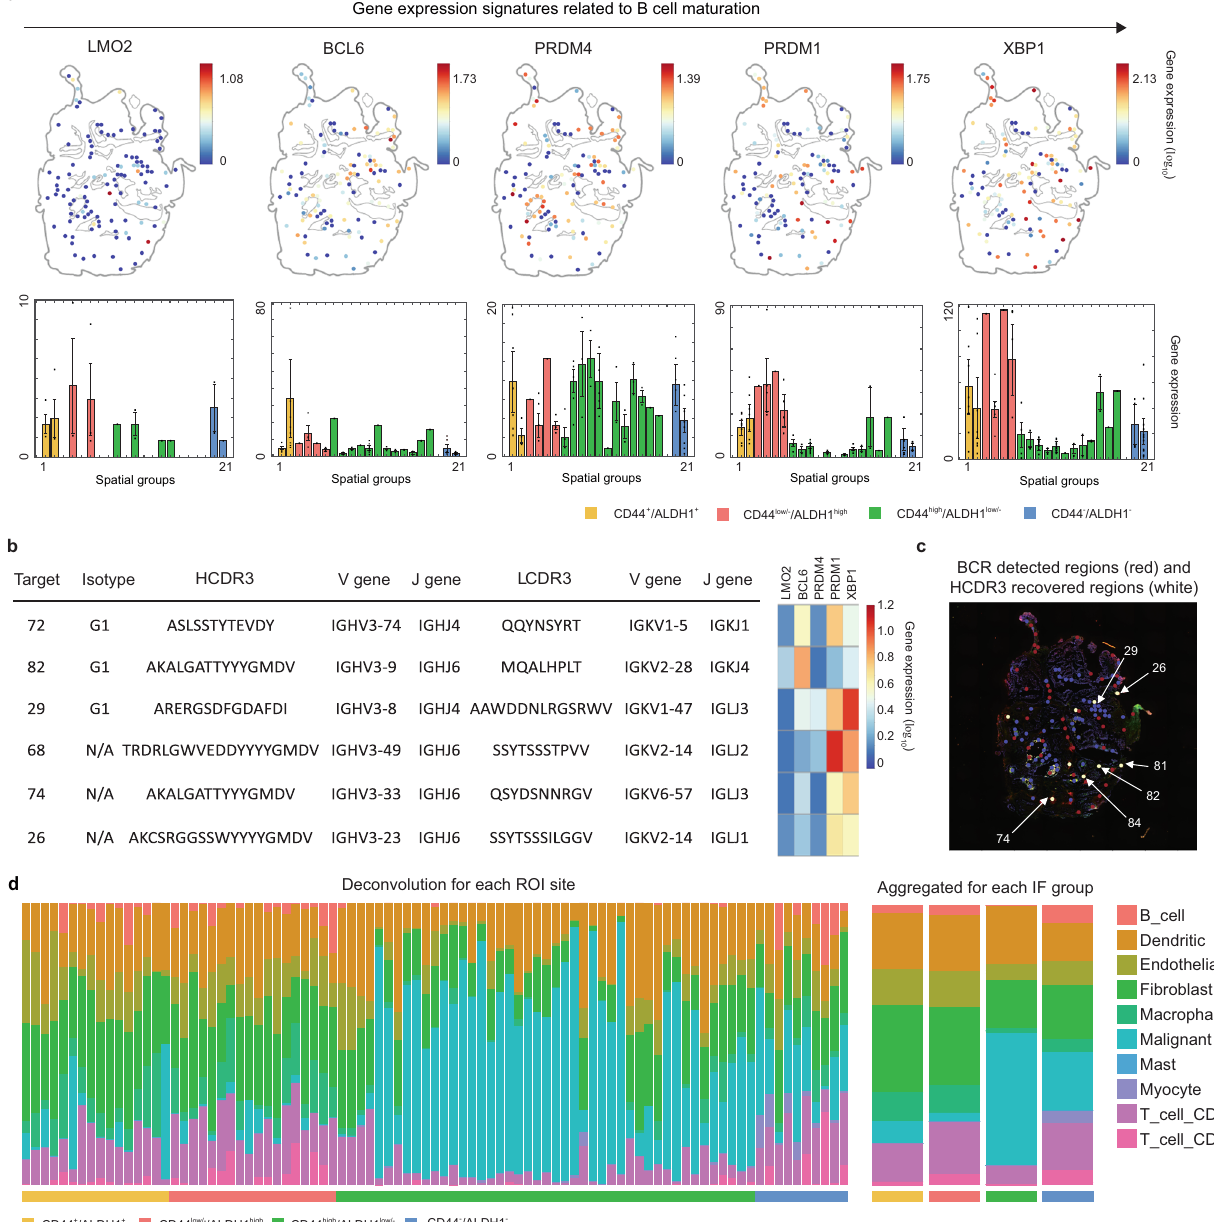
Fig. 4 Spatial analysis of the immune cell repertoire. a Spatial mapping of the signature genes related to B cell maturation ( n = 106 biologically independent samples (ROI)). Bar plot indicates mean value and error bar indicates standard deviation. b Six representative BCR sequences recovered using Select-seq and matched for gene expression related to B cell maturation. Overall, both heavy and light chain sequences from 42.9% of samples were recovered using Select-seq. Representative sequences including isotype, CDR3, matched V and J genes for each heavy and light chain. c Matched spatial context of recovered BCR sequences. Most of the BCRs were detected in the CD44low/ − /ALDH1high stromal region, and very few BCRs were detected in the CD44high/ALDH1low/ − duct region. Four of the six HCDR3 amino acid sequences were recovered from the CD44 − /low/ALDH1high region, and two were recovered from the CD44 − /ALDH1 − region. d Single-cell deconvolution of each ROI (left) and ROI group (right). Source data for b – d are provided as a Source Data fi